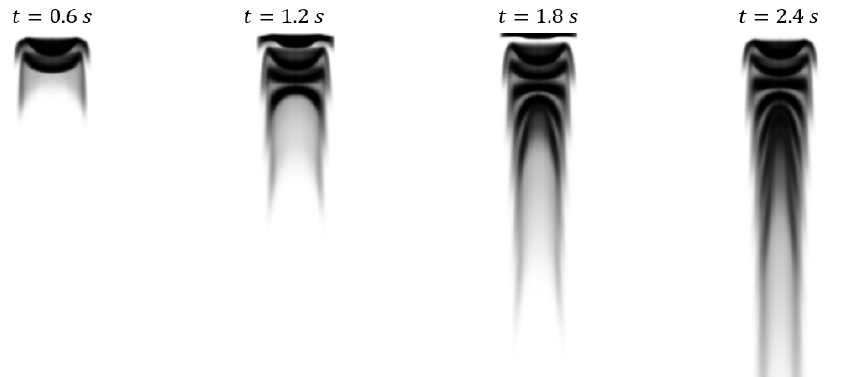
Figure 3. Projective images from case 4 generated from CFD results by using the Beer-Lambert law to simulate light passing through the domain.